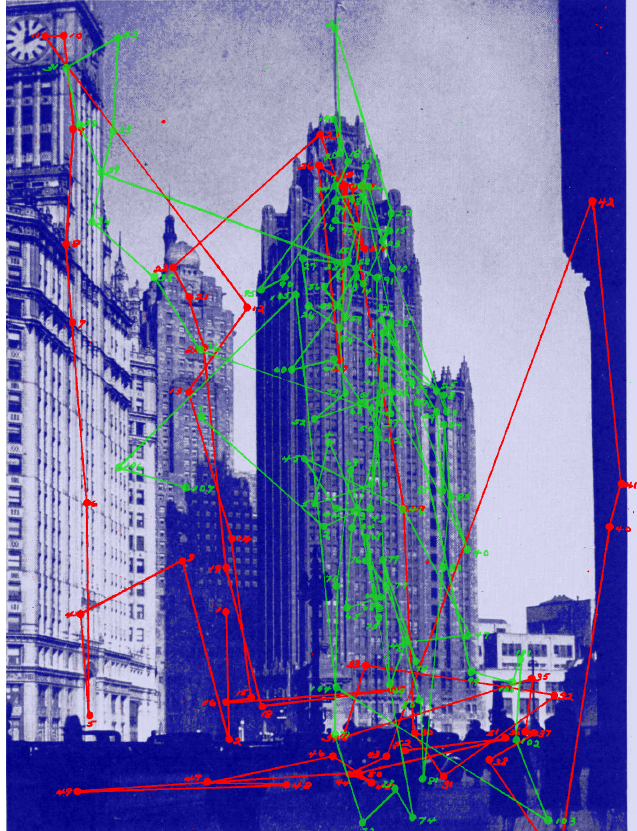
Figure 9. Directed viewing . Eye movements of one observer viewing a picture of the Chicago Tribune Tower without specific instructions (red) followed by directions to find a person looking out of a window in the Tower (green). (Adapted from Picture 43 and Plates LXV and LXVI in Buswell,